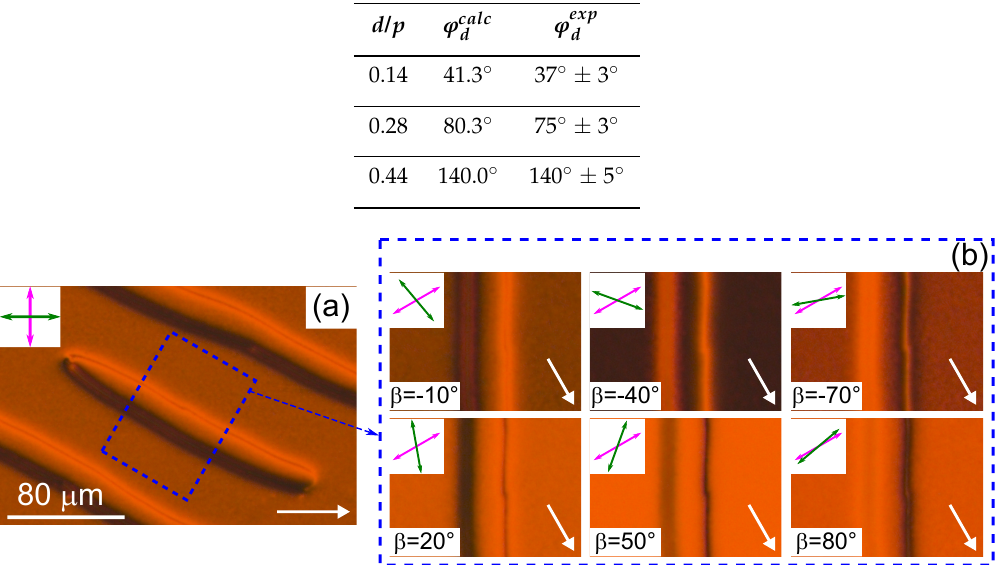
Figure 6. POM photos of cholesteric layer with confinement ratio d / p = 0.44 are taken using the interference filter ( λ = 602nm). The angle β between analyzer and rubbing direction of PVA film is 0 ◦ ( a ); The magnified area of 90 × 65 µ m of loop at different β angles ( b ). Polarizer is perpendicular to the rubbing direction. LC layer thickness is 6.5 µ